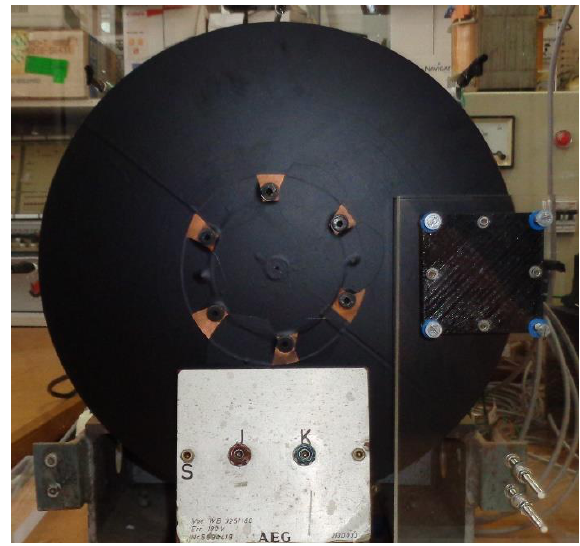
Figure 1. Front view of the disk and location of the thermometers installed to measure the ambient temperature around the disk.